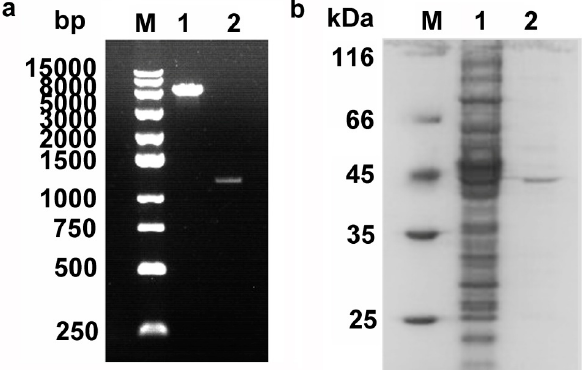
Figure 2. Cloning and purification of Pnserpin. ( a ) Cloning of the Pnserpin gene. Lane M, marker 250 bp DNA ladder; Lane 1, pET-28a(+); Lane 2, full-length DNA fragment of Pnserpin; ( b ) Purification of recombinant protein Pnserpin. Lane M, molecular mass marker; Lane 1, the crude extract; Lane 2, purified Pnserpin after Ni 2+ affinity chromatography.